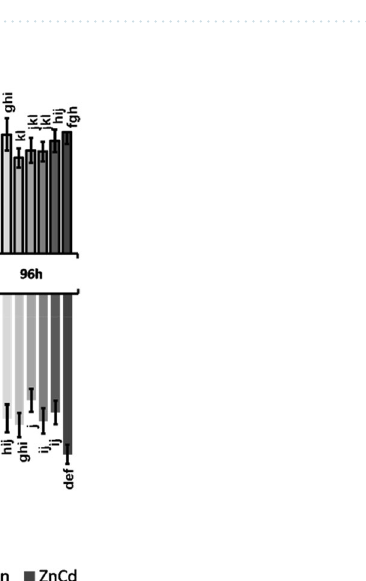
Figure 6. Generating of O 2.– and H 2 O 2 in B. juncea v. Malopolska roots using fluorescent microscopy. Plants were grown in Hoagland’s medium in the presence bimetals of 25 μmol of Pb(NO 3 ) 2 , CuSO 4 , CdCl 2 , and ZnSO 4 in combinations: CuPb, CuCd, CuZn, PbCd, PbZn, and ZnCd for 24 h. The roots of treated plants and control stained with DHE for 12 h ( A ) and DCFH-DA for 4 h ( B ).